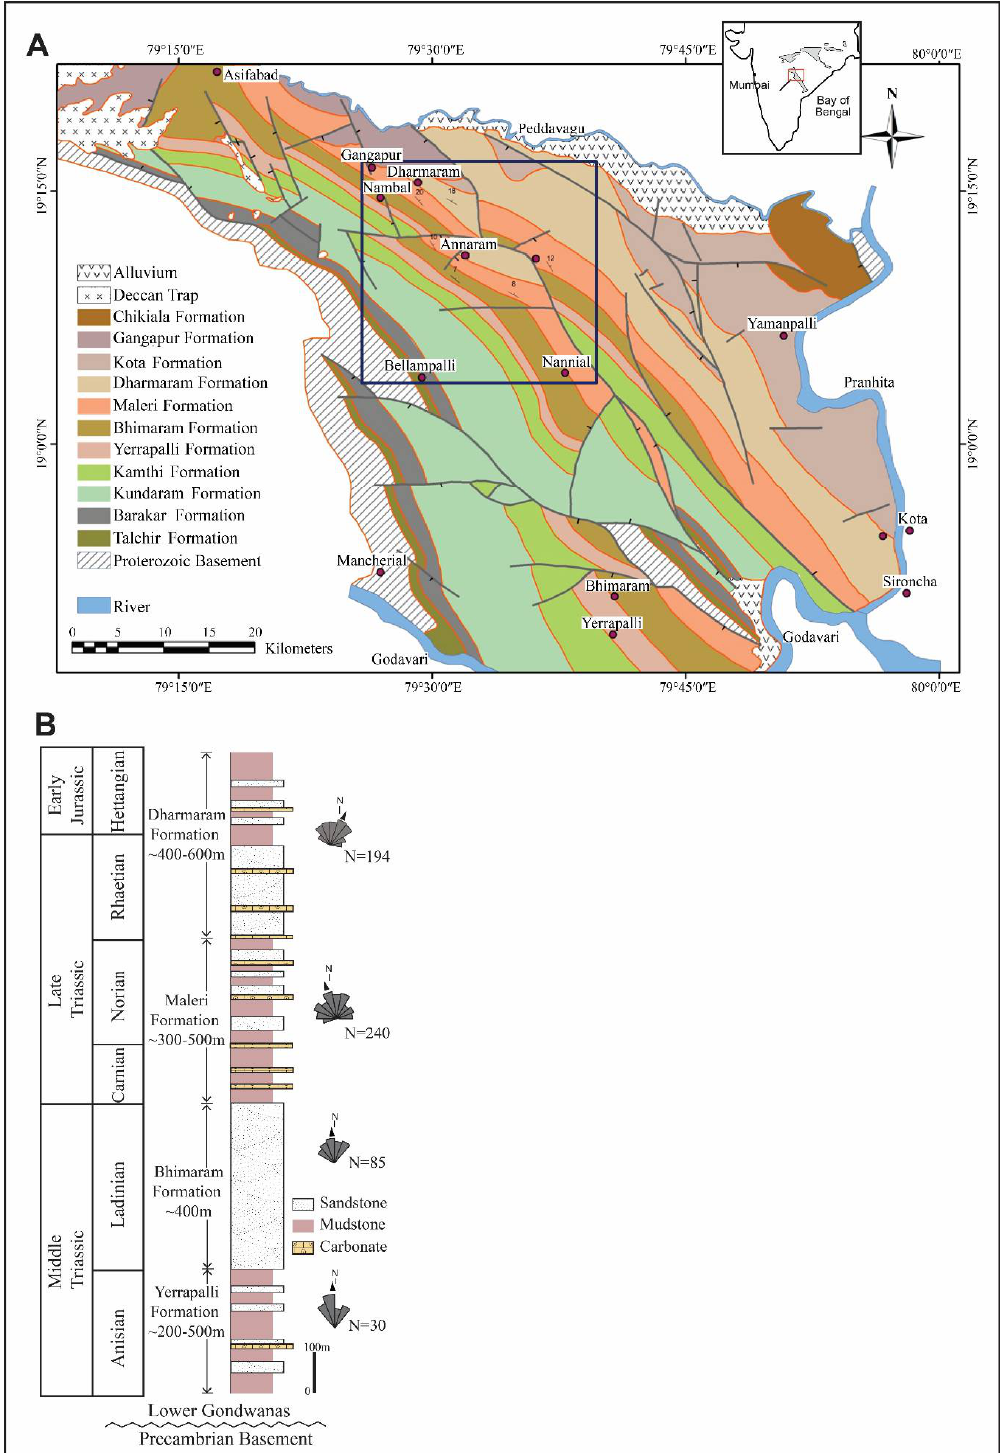
Figure 1. ( A ) Geological map of northern Pranhita-Godavari syn-rift basin, adapted from [39,50]. The study area is marked by a square. Inset shows the relative positions of the main Gondwana outcrops in the Indian subcontinent; the Pranhita-Godavari basin is marked (position of this map marked in red box). ( B ) Stratigraphic divisions and composite lithology of the four Mesozoic formations discussed in this study are shown. Paleocurrent data documented for this study, from all the four formations, is supported by earlier research work as well